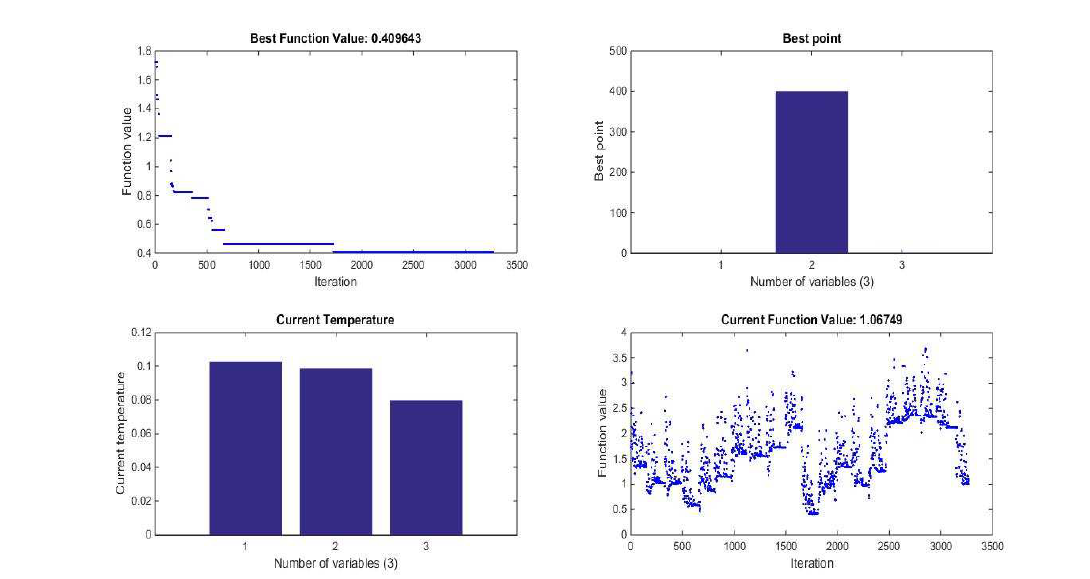
Fig. 16. Performance of Simulated Annealing Algorithm (R